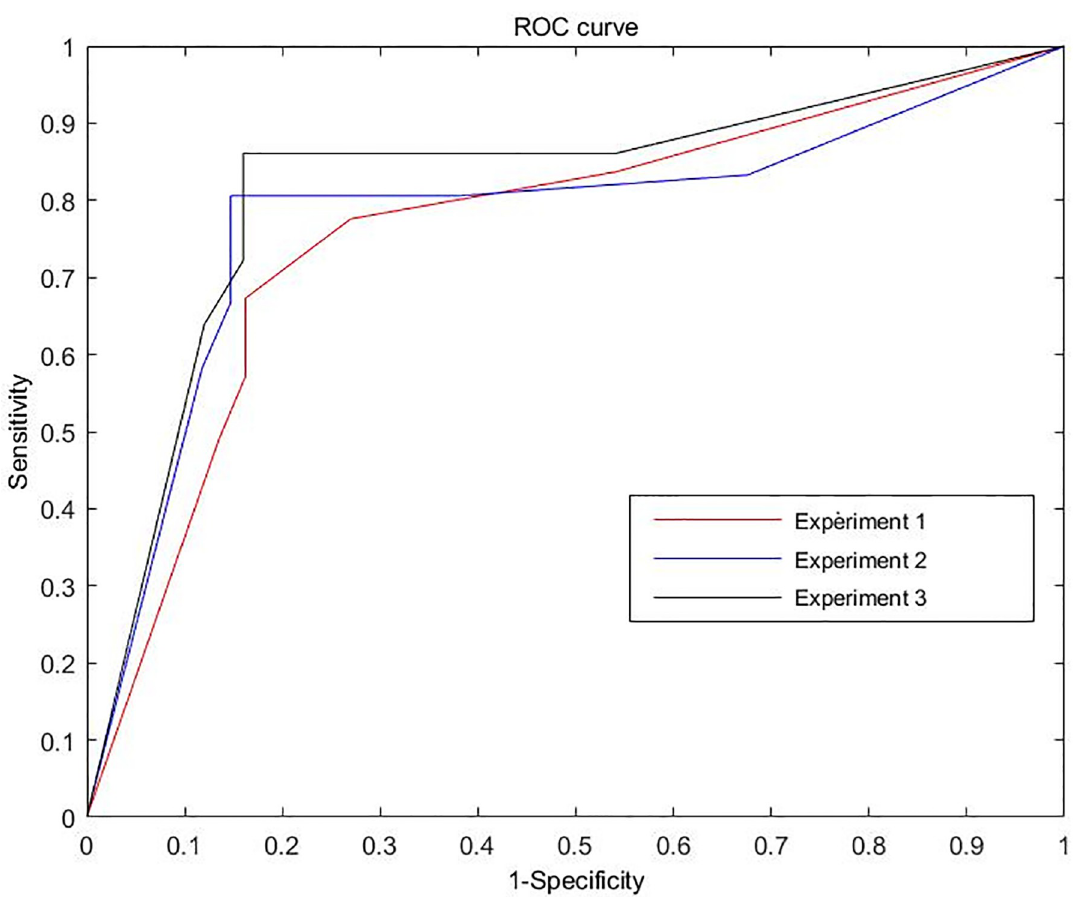
Fig 9. Receiver-operating characteristic curves of CDG for the three experiments. The areas under the three ROC curves were 0.759 (the 95% confidence interval 0.653 to 0.865), 0.756(the 95% confidence interval 0.632 to 0.881), and 0.799(the 95% confidence interval 0.691 to 0.907),